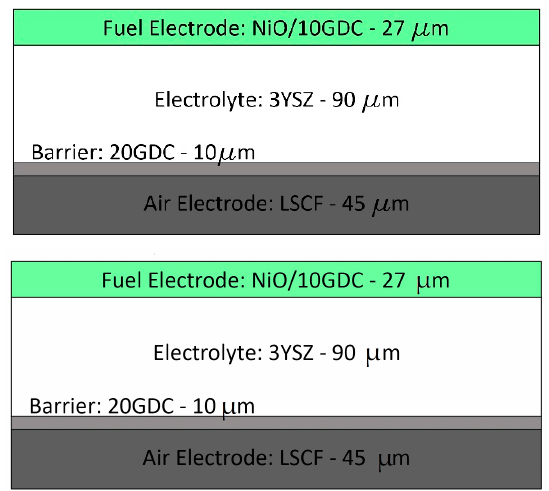
Figure 1. Schematic representation of the Sunfire MEA with its functional layers. Table 1. List of the cell layers with their composition and nominal thickness.